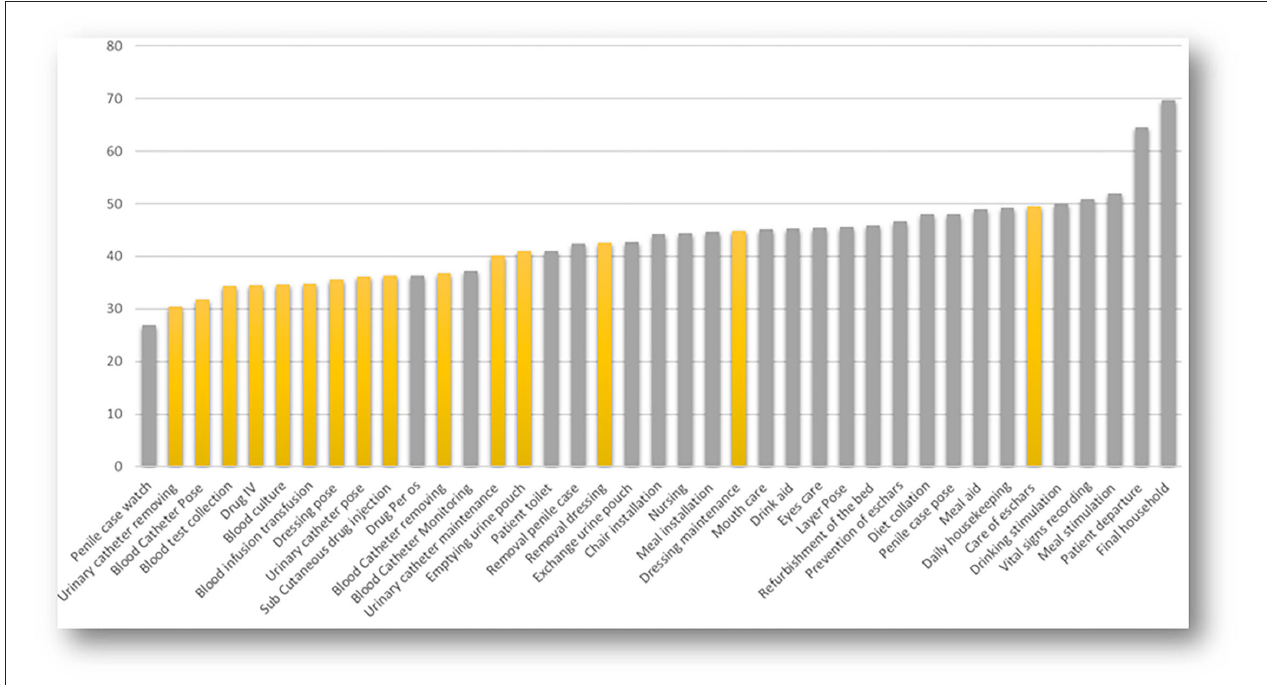
FIGURE 1 | Distribution of lack of compliance (%) to hand hygiene in aseptic task procedure (WHO Moment 2) vs. standard task procedure nursing. Hand hygiene is better performed when the nursing is in the category aseptic task (yellow) compare to standard precaution (gray) that were 1,678 (37%)/12,070 (47.1%) p < 2.2 E-16.